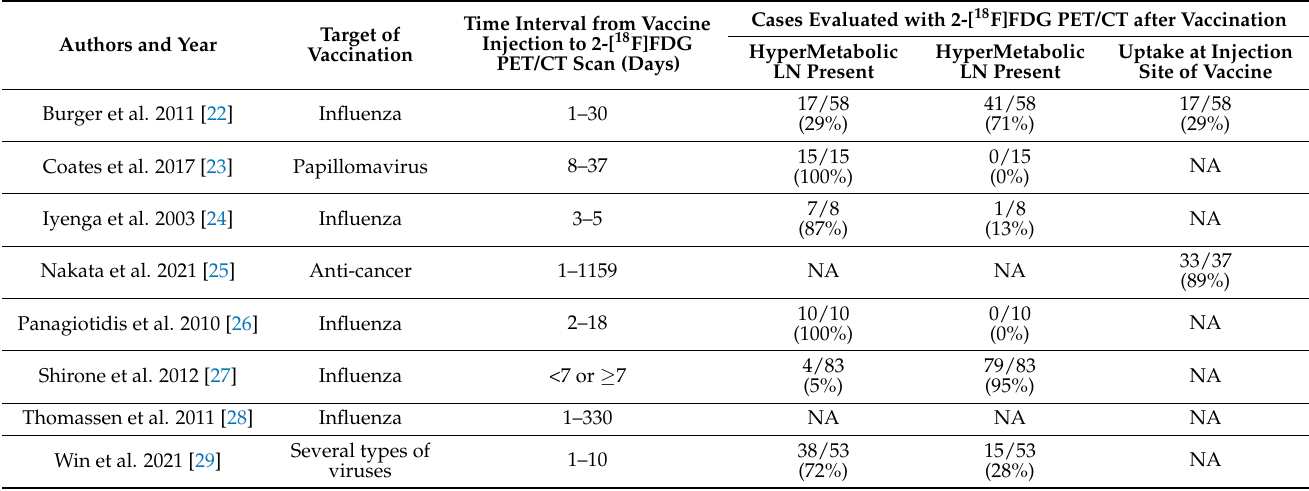
Table 4. Data on the prevalence of hypermetabolic lymph nodes at 2-[ 18 F]FDG PET/CT after injection of other vaccines beyond